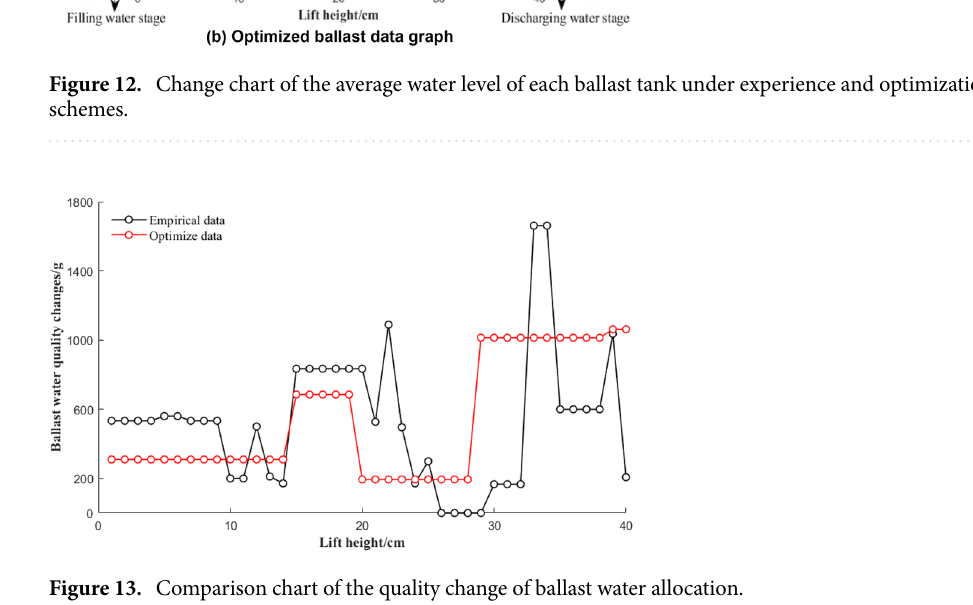
Figure 13. Comparison chart of the quality change of ballast water